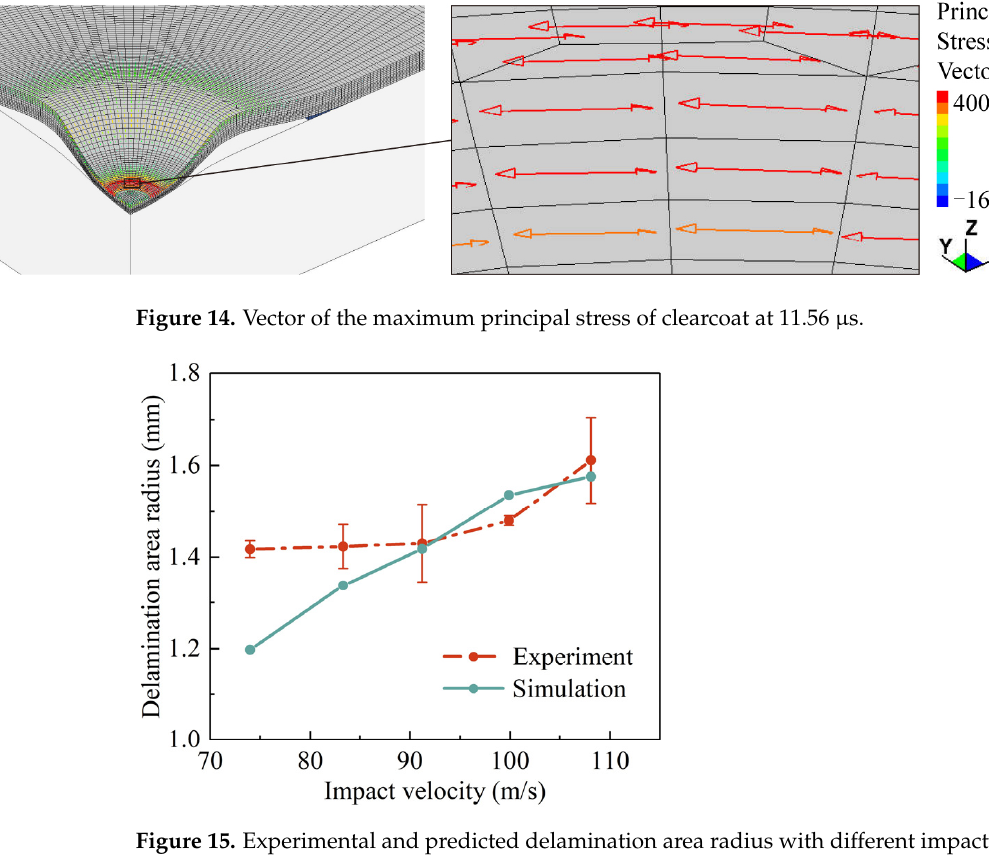
Coatings 2023 , 13 , x 18 of 25 Figure 14. Vector of the maximum principal stress of clearcoat at 11.56 μ s.